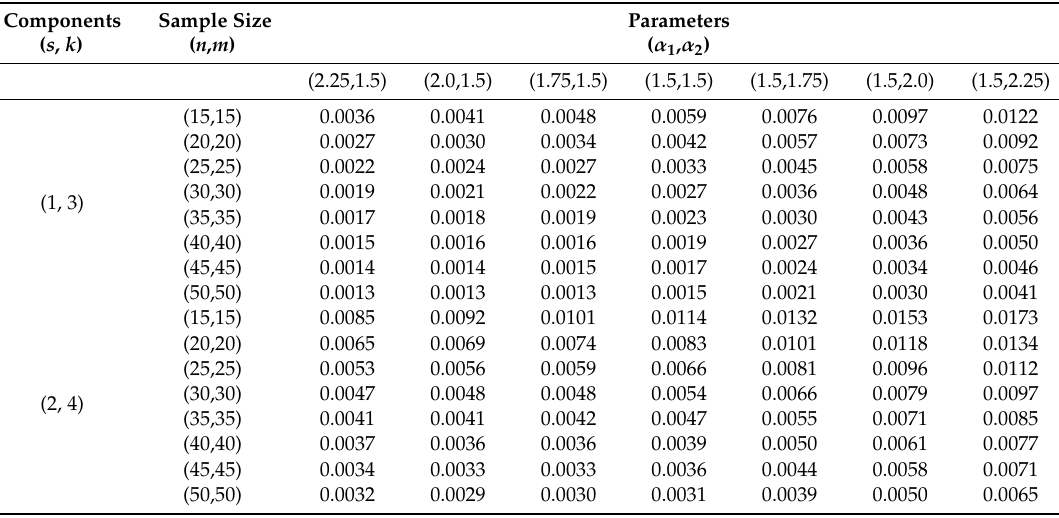
Table 2. Mean squared error (MSE) of the simulated estimates of reliability R s , k